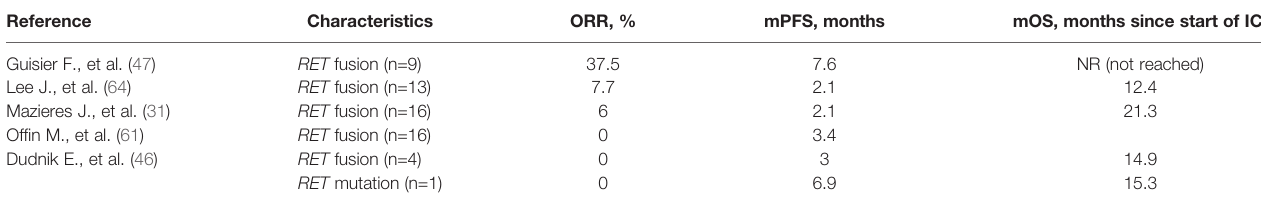
TABLE 4 | Ef fi cacy of ICIs in NSCLS with RET mutations.